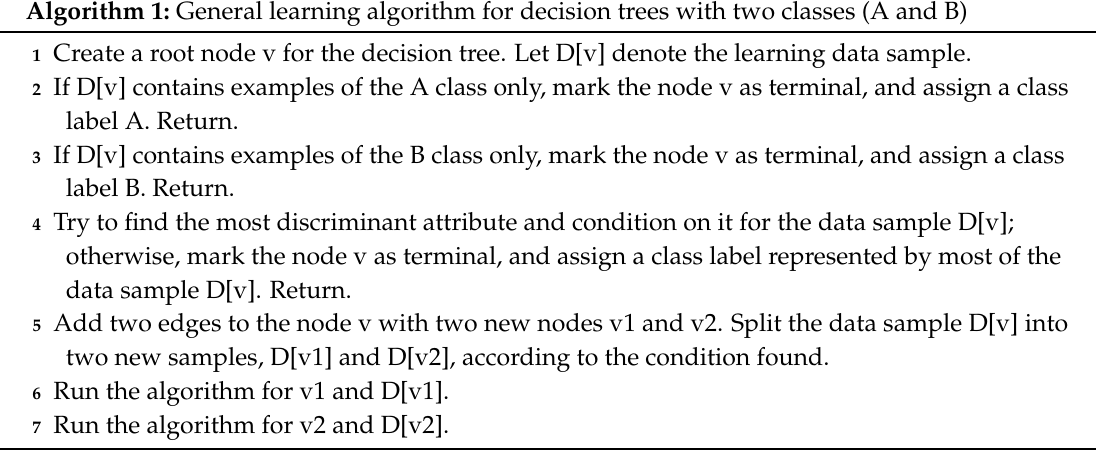
Algorithm 1: General learning algorithm for decision trees with two classes (A and